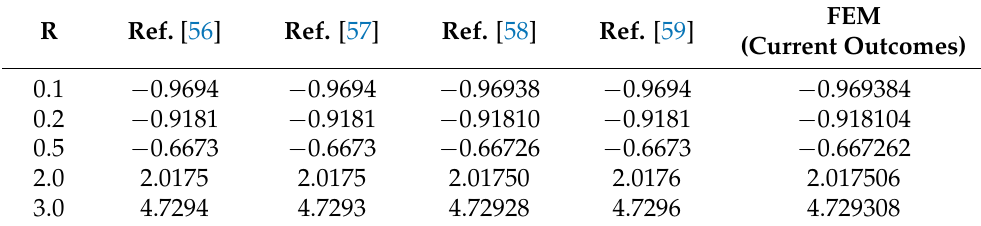
Table 2. Comparison of C f Re 1/2 x against R , when not considering other involved parameters.